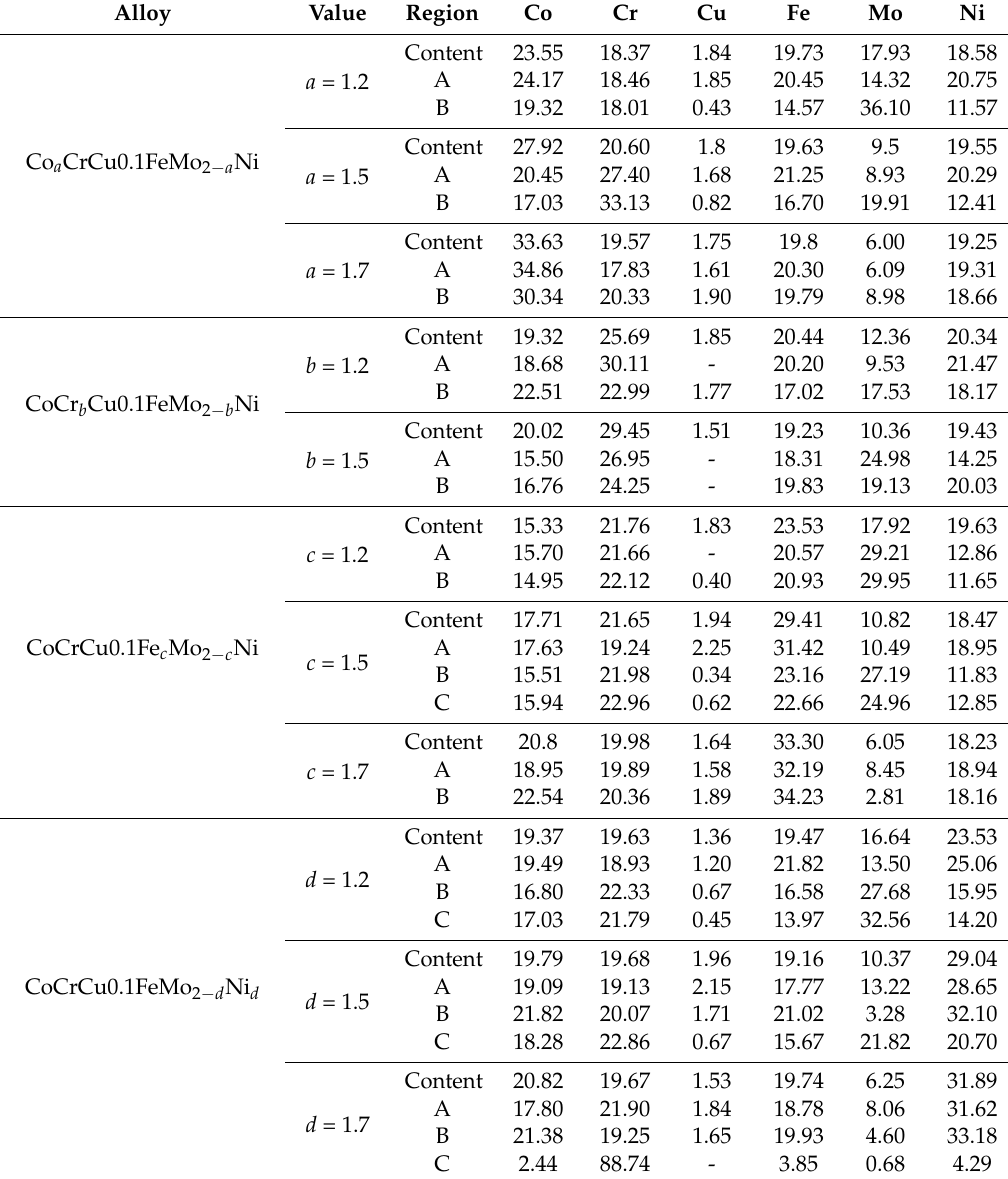
Table 2. The components of different regions in microstructures of CoCrCu 0.1 FeMoNi-based high-entropy alloys